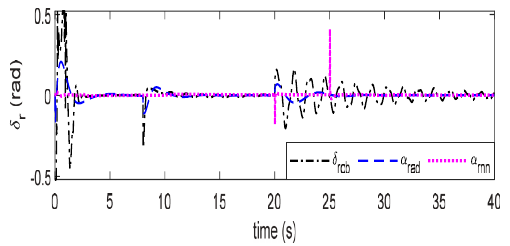
Figure 11. Control surface deflection angles of δ r